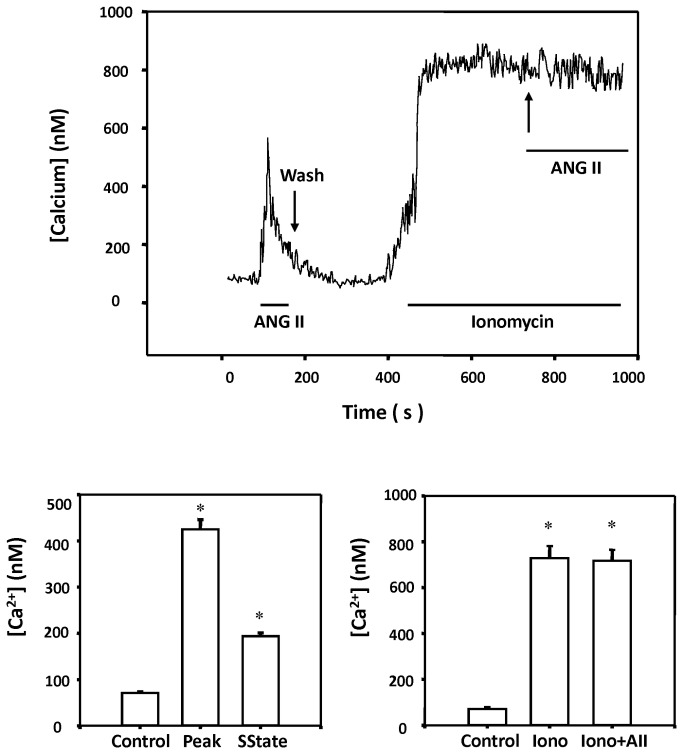
Effect of ANG II on intracellular calcium response in renal VSM cells.The upper panel presents a representative tracing of a [Ca2+]i response of a single renal microvessel VSM cell to ANG II (10-7 M) bathed in PSS before and after addition of ionomycin (10-6 M). ANG II elicited a rise in [Ca2+]i in renal VSM cells under control conditions. Addition of ionomycin raised baseline [Ca2+]i and under these conditions ANG II had no additional effect on [ Ca2+]i. The lower left panel summarizes the effects of on peak and plateau [Ca2+]i responses to ANG II (10-7 M) in the renal VSM cells. The right panel presents the [Ca2+]i response to ANG II after addition of ionomycin. * indicates a significant rise in [Ca2+]i over baseline. Mean values + SE recorded from 45-70 cells (5-10 cells per experiment) isolated from 9 different renal VSM cell isolation are presented.